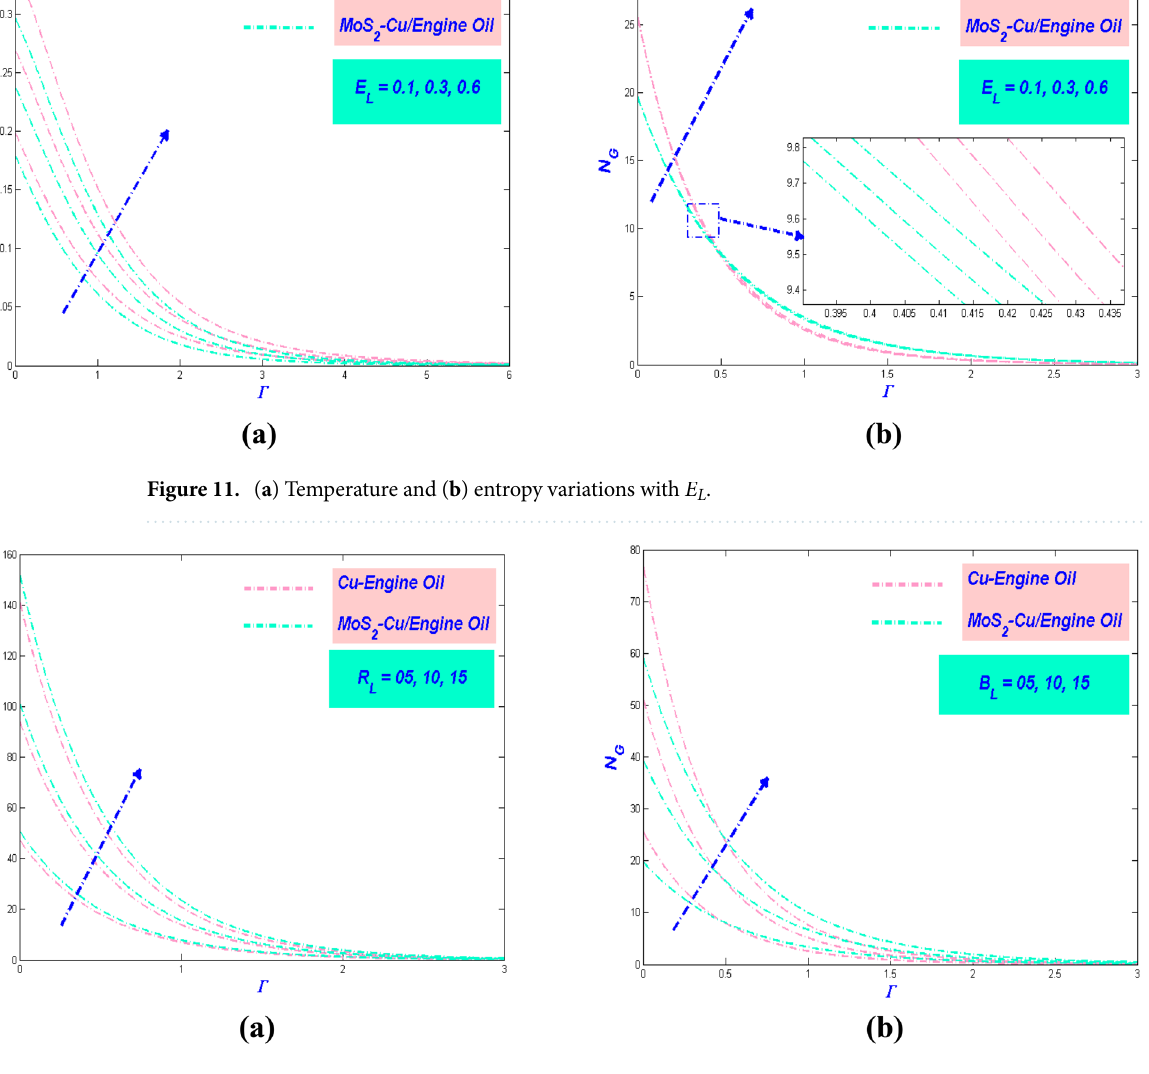
Figure 12. Entropy variations versus ( a ) R e and ( b ) B r